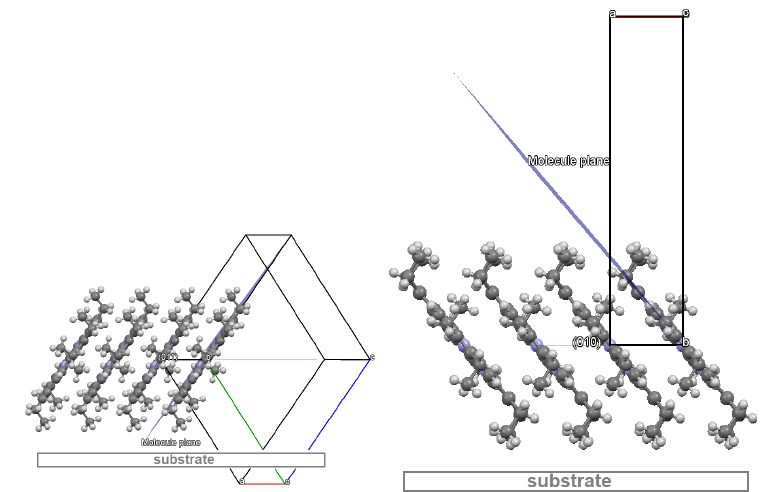
Figure A2. Crystal packing of Cu-EtioP-III ( top center ), orientation of molecules: ( bottom left )—(011) plane parallel to the substrate, ( bottom right )—(010) plane parallel to the